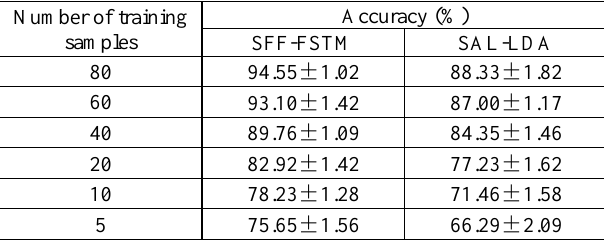
Table 5. Performance of SFF-FSTM and SAL-LDA for the UC Merced dataset with limited training samples